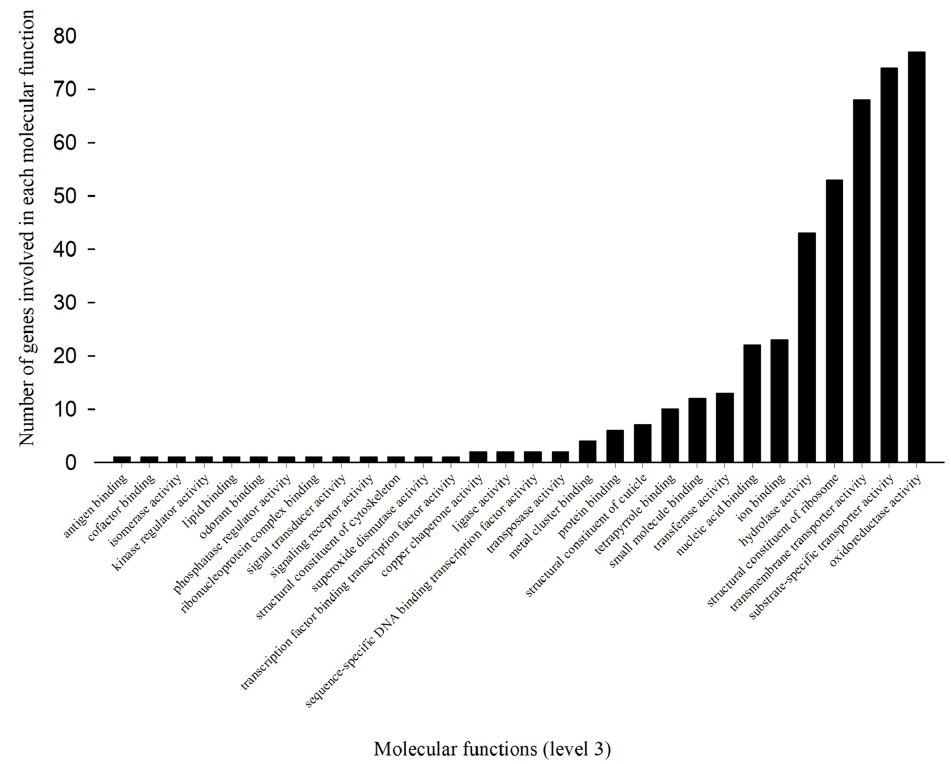
Figure 3. Variable number of up-regulated genes associated with each molecular function in permethrin-selected tarnished plant bug.